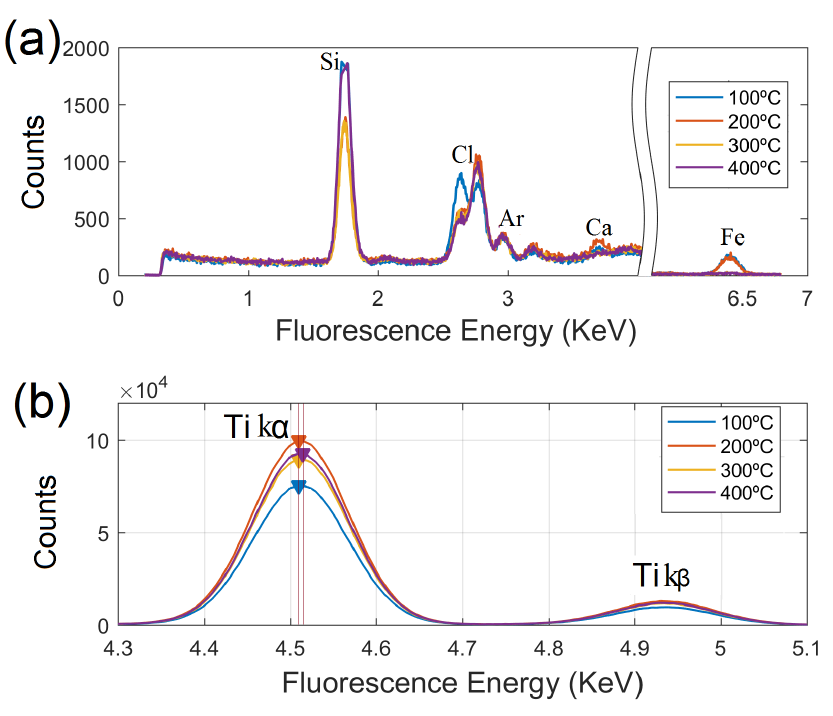
Figure 3. TRXF spectra of nano-TiO samples prepared by sol-gel synthesis at ambient temperature 2 followed by calcination up to 400 ◦ C. ( a , b ) Ti K α and K β fluorescence lines in the